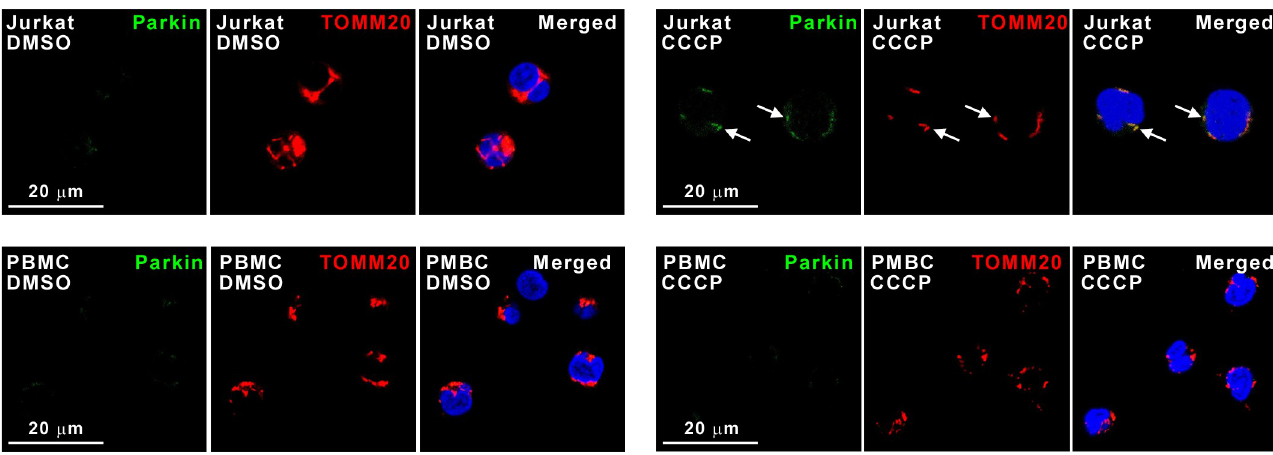
Fig 7. Parkin does not accumulate on CCCP-induced depolarised PBMC mitochondria. Fluorescent micrographs of Jurkat and PBMC samples, treated with DMSO (vehicle) or CCCP, followed by immunostaining for Parkin (fluorescent green) and the mitochondrial marker TOMM20 (fluorescent red). Nuclei were counterstained fluorescent blue with DAPI. Arrows indicate Parkin co-localising with mitochondria in Jurkat cells.